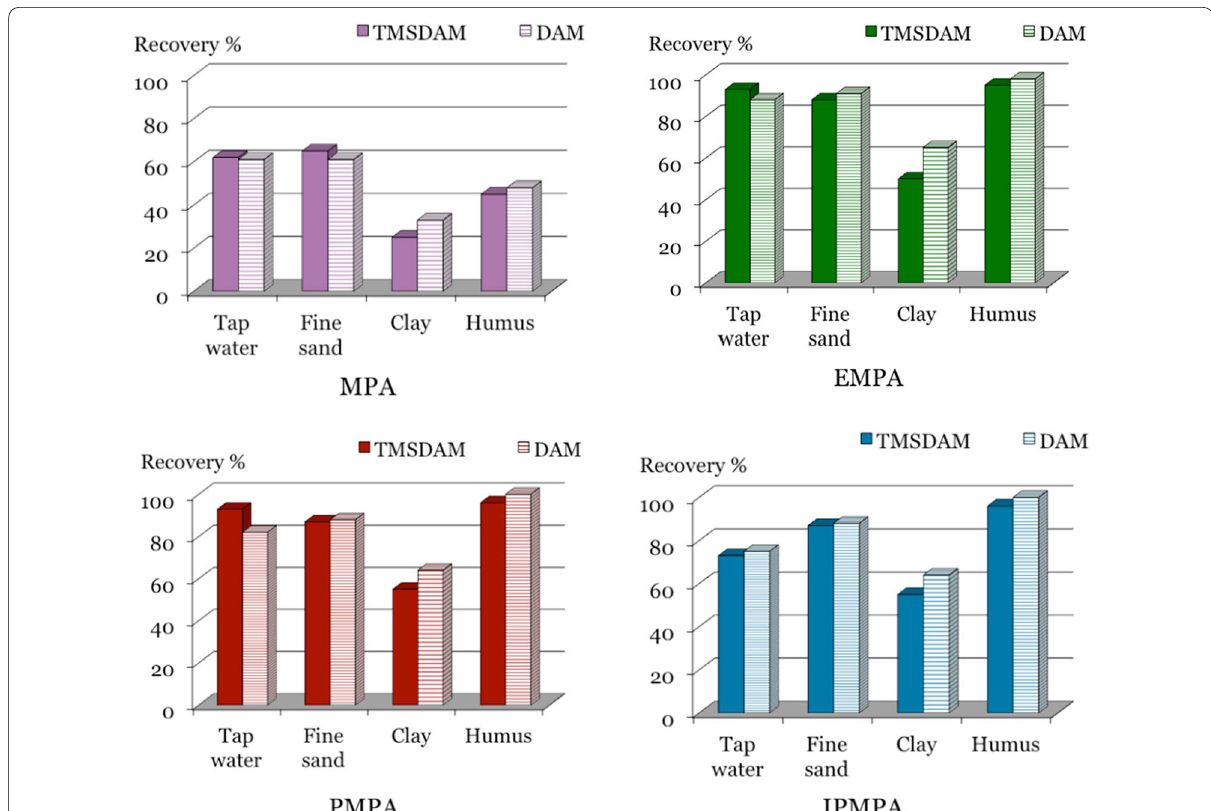
Fig. 2 Recovery (%) of APAs (10 µg/ml) in tap water and aqueous extracts of different soil samples. The aqueous extract was cation‑exchanged and evaporated to dryness, and the residue was dissolved in AcMeOH before TMSDAM